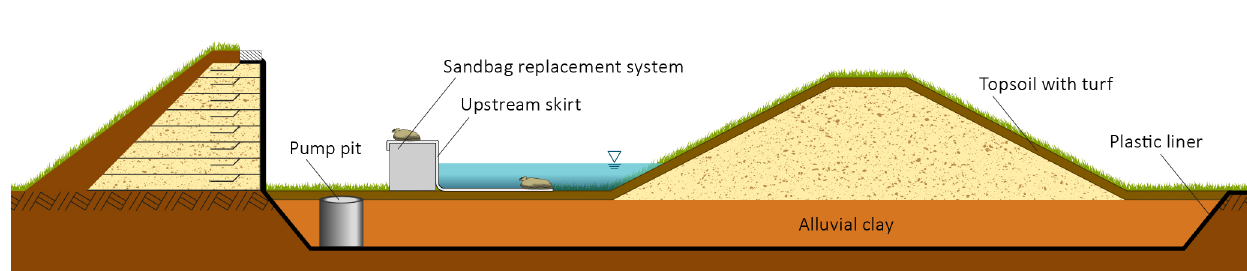
Figure 7. Illustration of the test set-up in the test facility. An SBRS with an upstream skirt is shown.